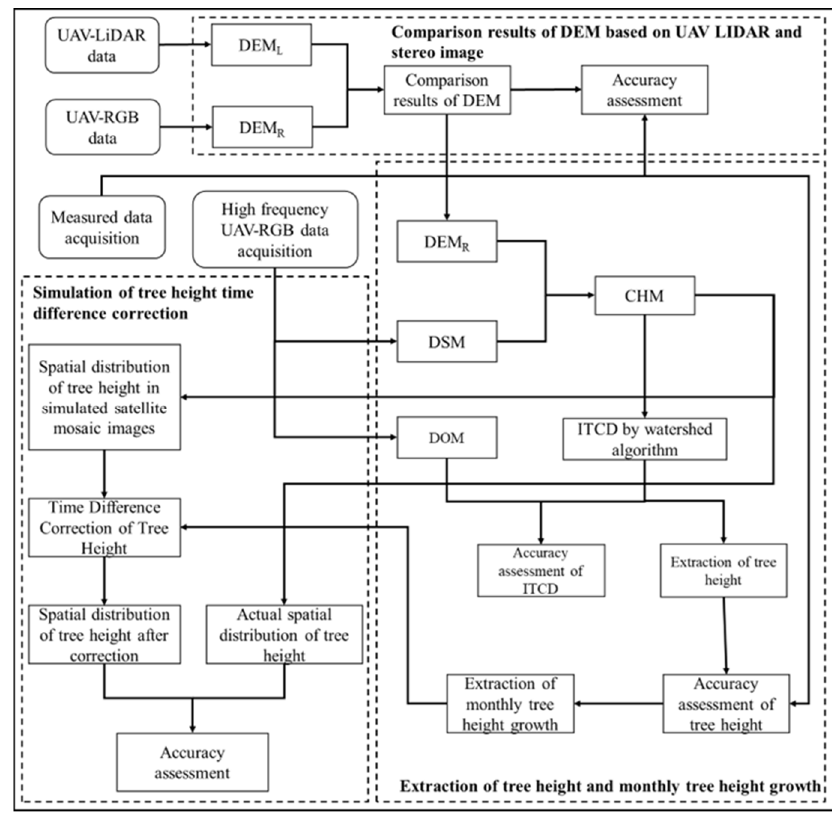
Figure 2. Flowchart of the overall